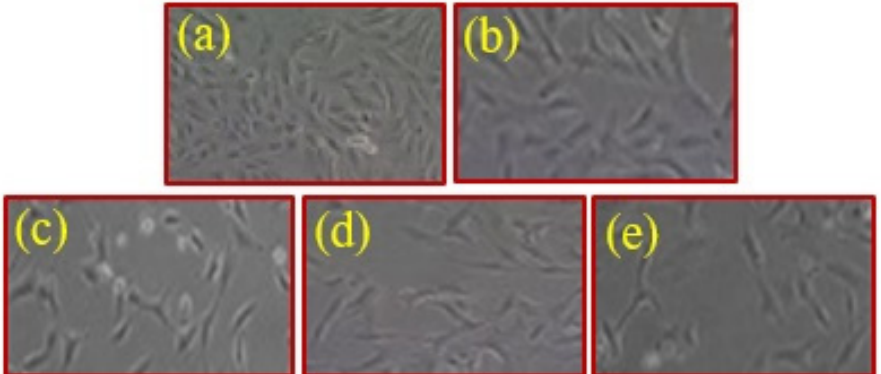
Figure 8. Images of MCF7 cells for the control ( a ) and in the presence of variable concentrations of CA@Ag (0.1) /ZnO nanocomposite 0.50, 1, 2, and of 3 mg/mL ( b – e ) at a magnification of X = 600.